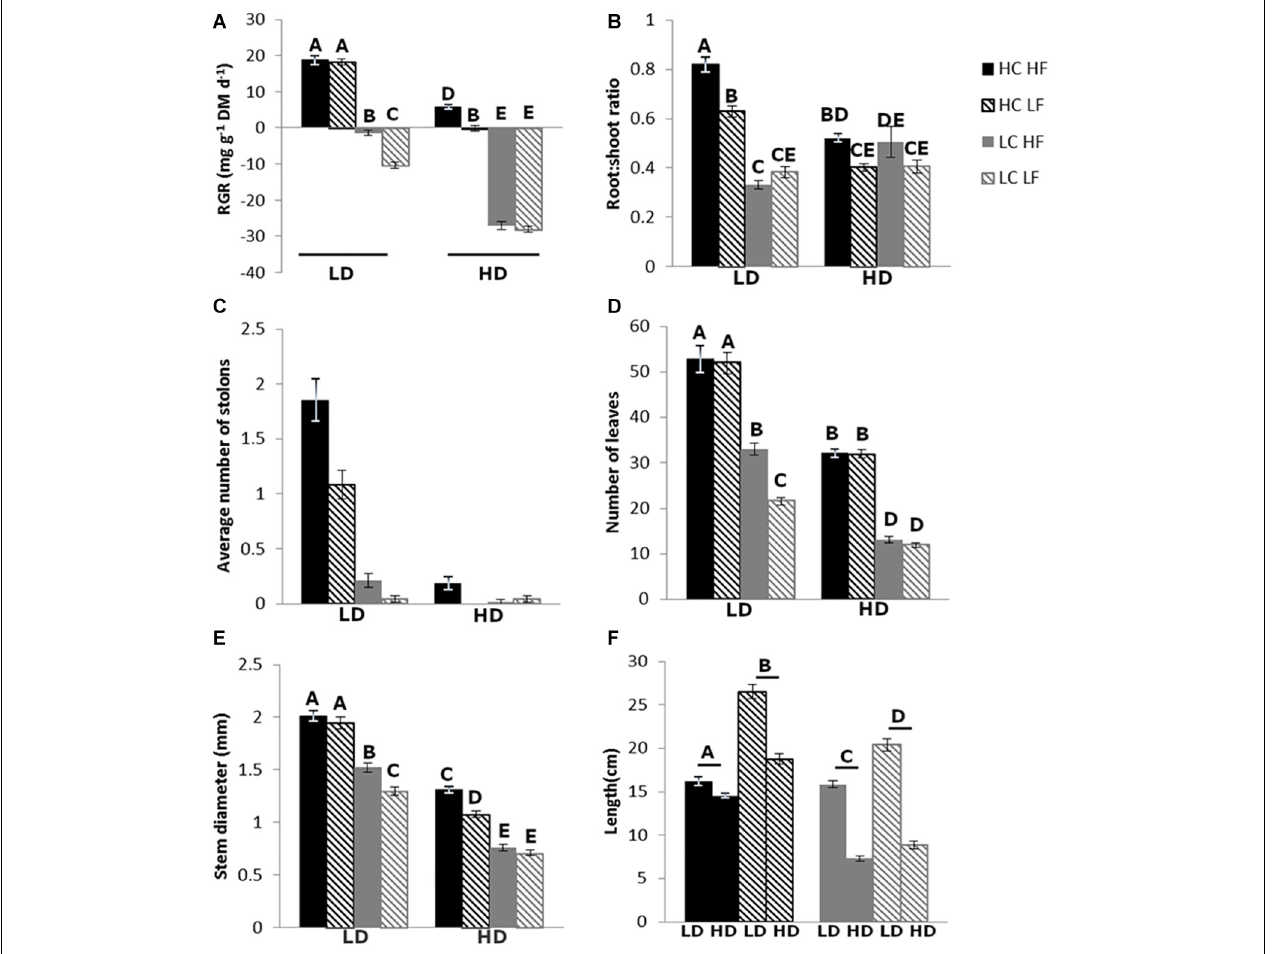
FIGURE 2 | Relative growth rate (A) , root:shoot ratio (B) , number of stolons (C) , number of leaves (D) , stem diameter (E) , and length of the longest stem (F) . The letters above the graph indicate significant differences ( p < 0.05, n = 48), tested with three-way ANOVA. In panels (A,B,D,E) three-way interactions are shown, in panel (C) there were no interactions, just main effects of flow velocity, carbon and DOC, and in panel (F) a CO 2 *Flow interaction.